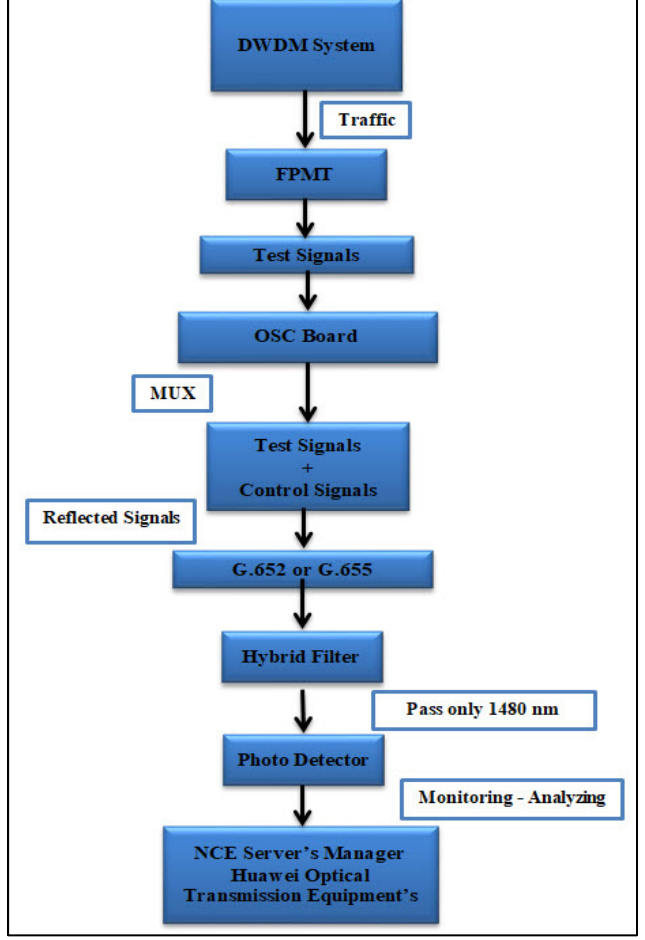
Figure 4. The working principle and signal flow over the proposed FPMT technique.